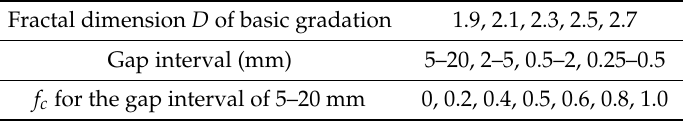
Table 1. Program of vibrating compaction tests.